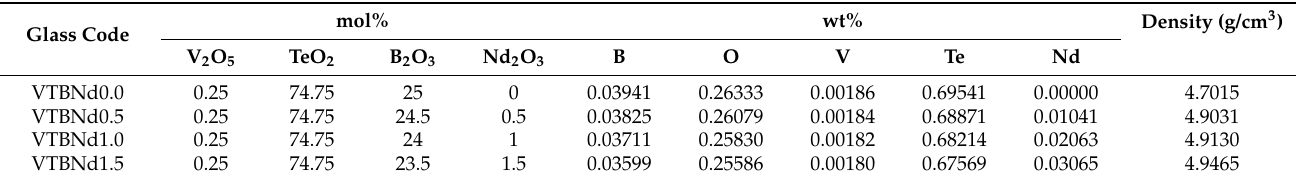
Table 1. Chemical compositions and density for glass samples.